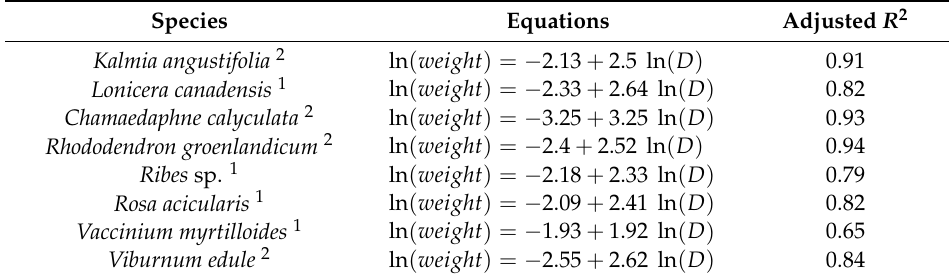
Table A1. Equations and adjusted R 2 from linear regressions analysis linking shrub weight (g) with stem basal diameter (cm) by species. All equations and coefficients were significant with a p -value ≤ 0.05.